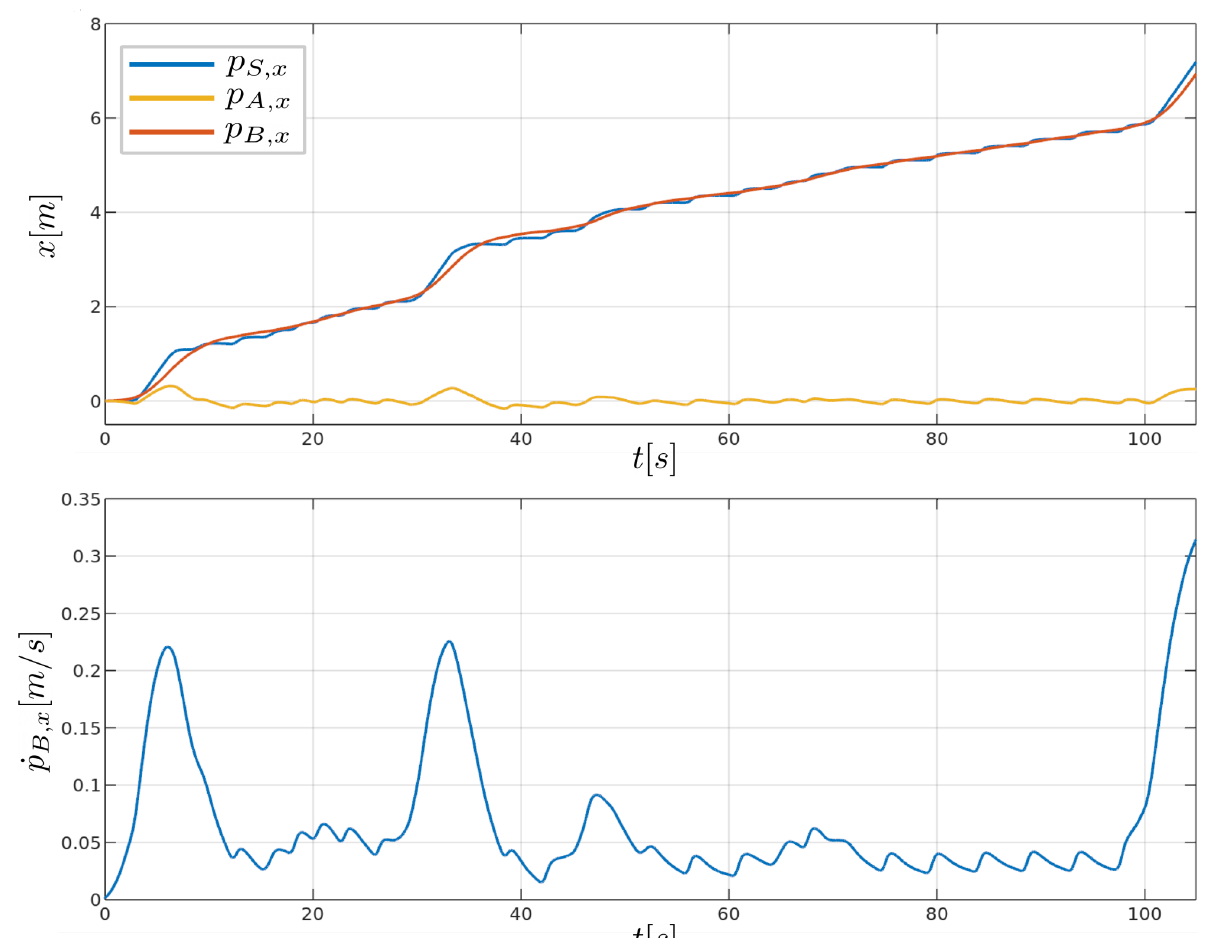
Figure 12. The upper diagram shows the x component of the reference trajectory p S , x , along with the robot arm and mobile base components, p A , x and p B , x , respectively. The bottom graph shows the forward velocity of the vehicle during the